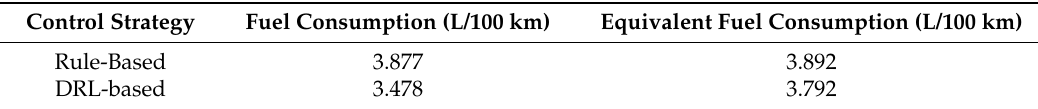
Table 4. Comparison of the results under NEDC.